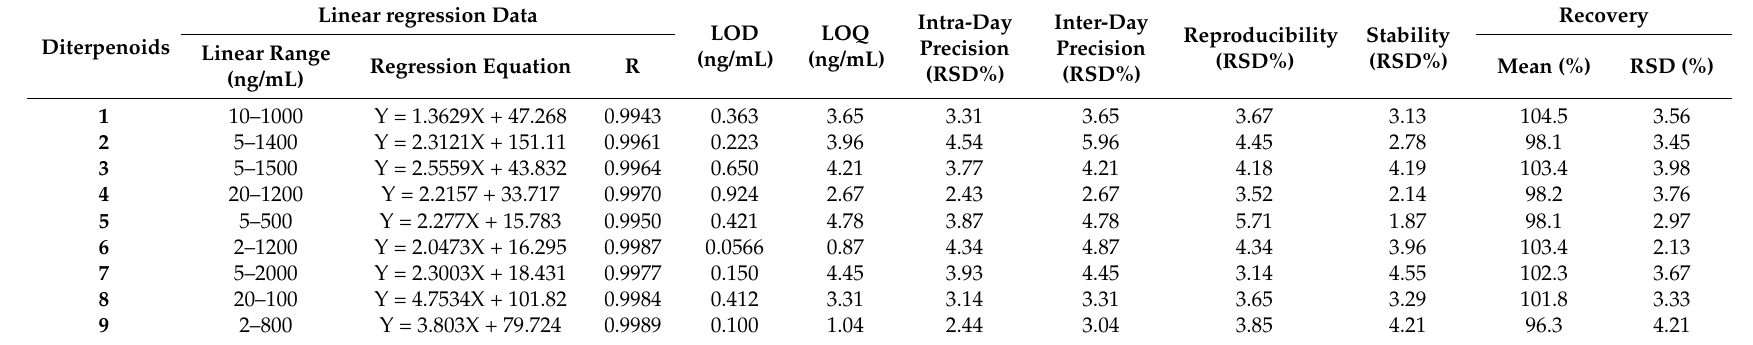
Table 2. Linear regression parameters, precision, accuracy, reproducibility, stability, and average recoveries of UHPLC–MRM analysis for the nine diterpenoids of Croton crassifolius